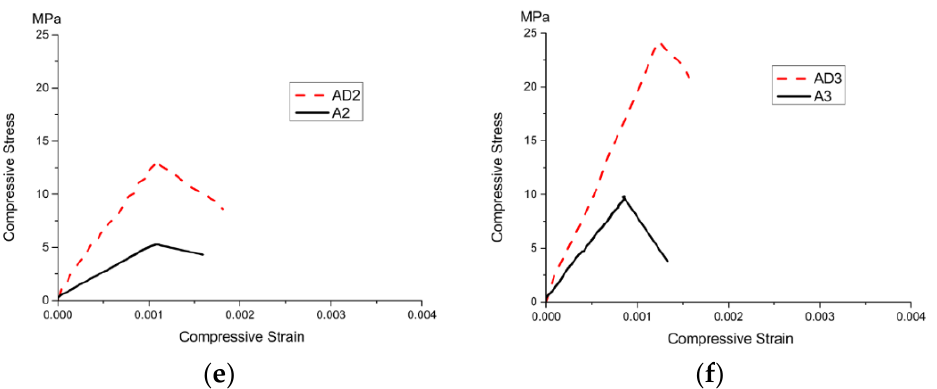
Figure 13. Compressive stress–strain curves. ( a ) Compressive stress–strain curves of Group A; ( b ) Compressive stress–strain curves of Group AD; ( c ) Compressive stress–strain curves of all specimens; ( d ) Comparison of stress–strain curves between A1 and AD1; ( e )Comparison of stress–strain curves between A2 and AD2; ( f ) Comparison of stress–strain curves between A3 and AD3.